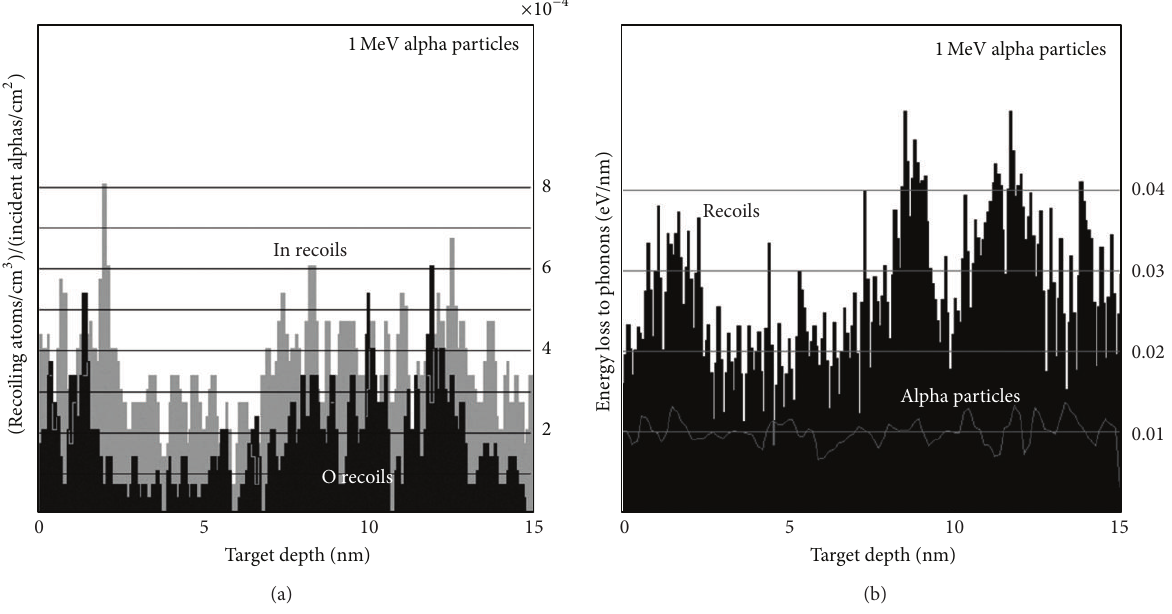
Figure 3: Results of irradiating a 15nm thick InO 𝑥 film by a beam of 10 4 alpha particles with 1MeV energy. (a) Distribution of the concentration of the displaced indium and oxygen atoms (recoils) per unit alpha particle fluence. (b) Energy loss to phononic excitations per unit depth by alphas and